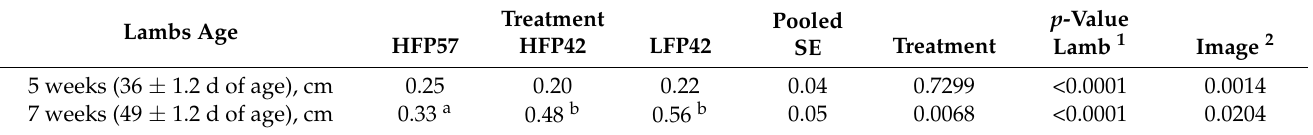
Table 5. Effect of three lamb-rearing treatments (HFP57, high fibre concentrate pellets and milk feeding to 57 d of age; HFP42, high fibre concentrate pellets and early weaning at 42 d of age; LFP42, low fibre concentrate pellets and early weaning at 42 d of age) on lamb rumen dorsal wall thickness at five and seven weeks of age as measured from Ultrasound scanned images (SE, standard error).